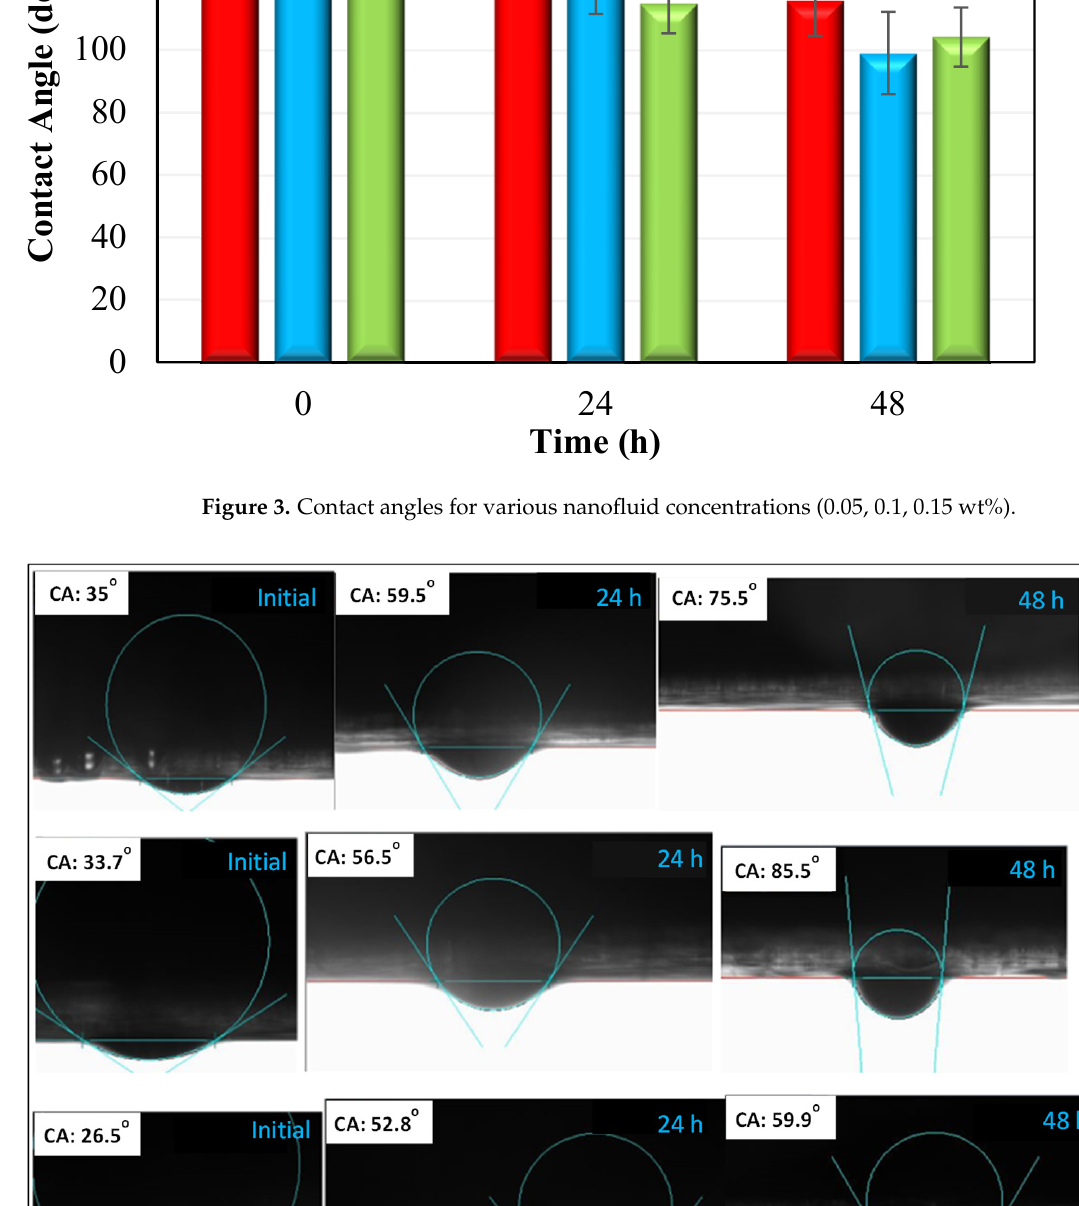
Figure 4. Contact angle measurements from OCA 15EC ( a ) 0.05 wt% ( b ) 0.1 wt % ( c ) 0.15 wt%.